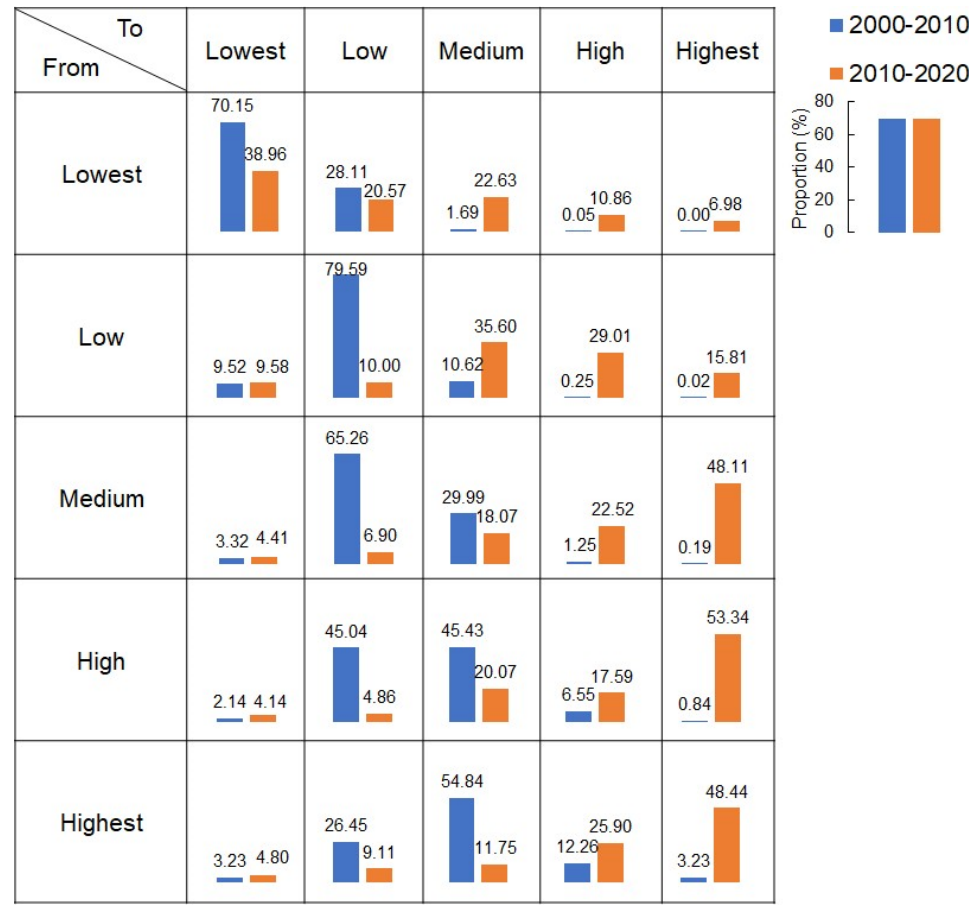
Figure 6. Interconversion proportions of different biomass carbon density levels from 2000 to 2020. The numbers on the histogram represent the ratio of the transition area to the area of the initial carbon density level.